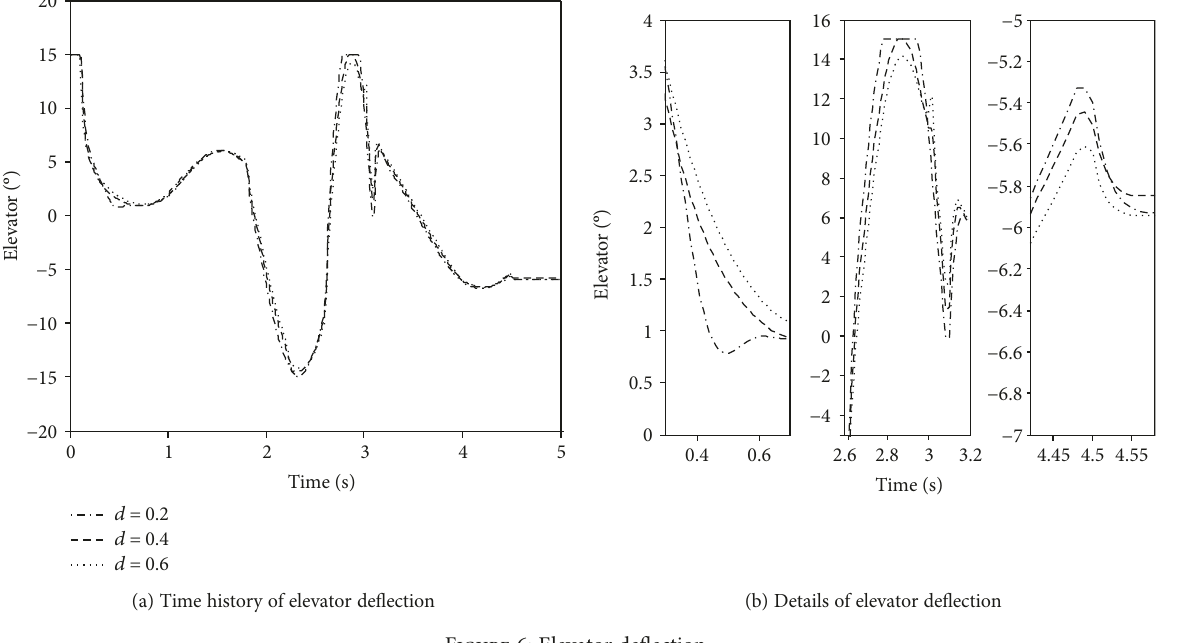
Figure 6: Elevator de fl ection.